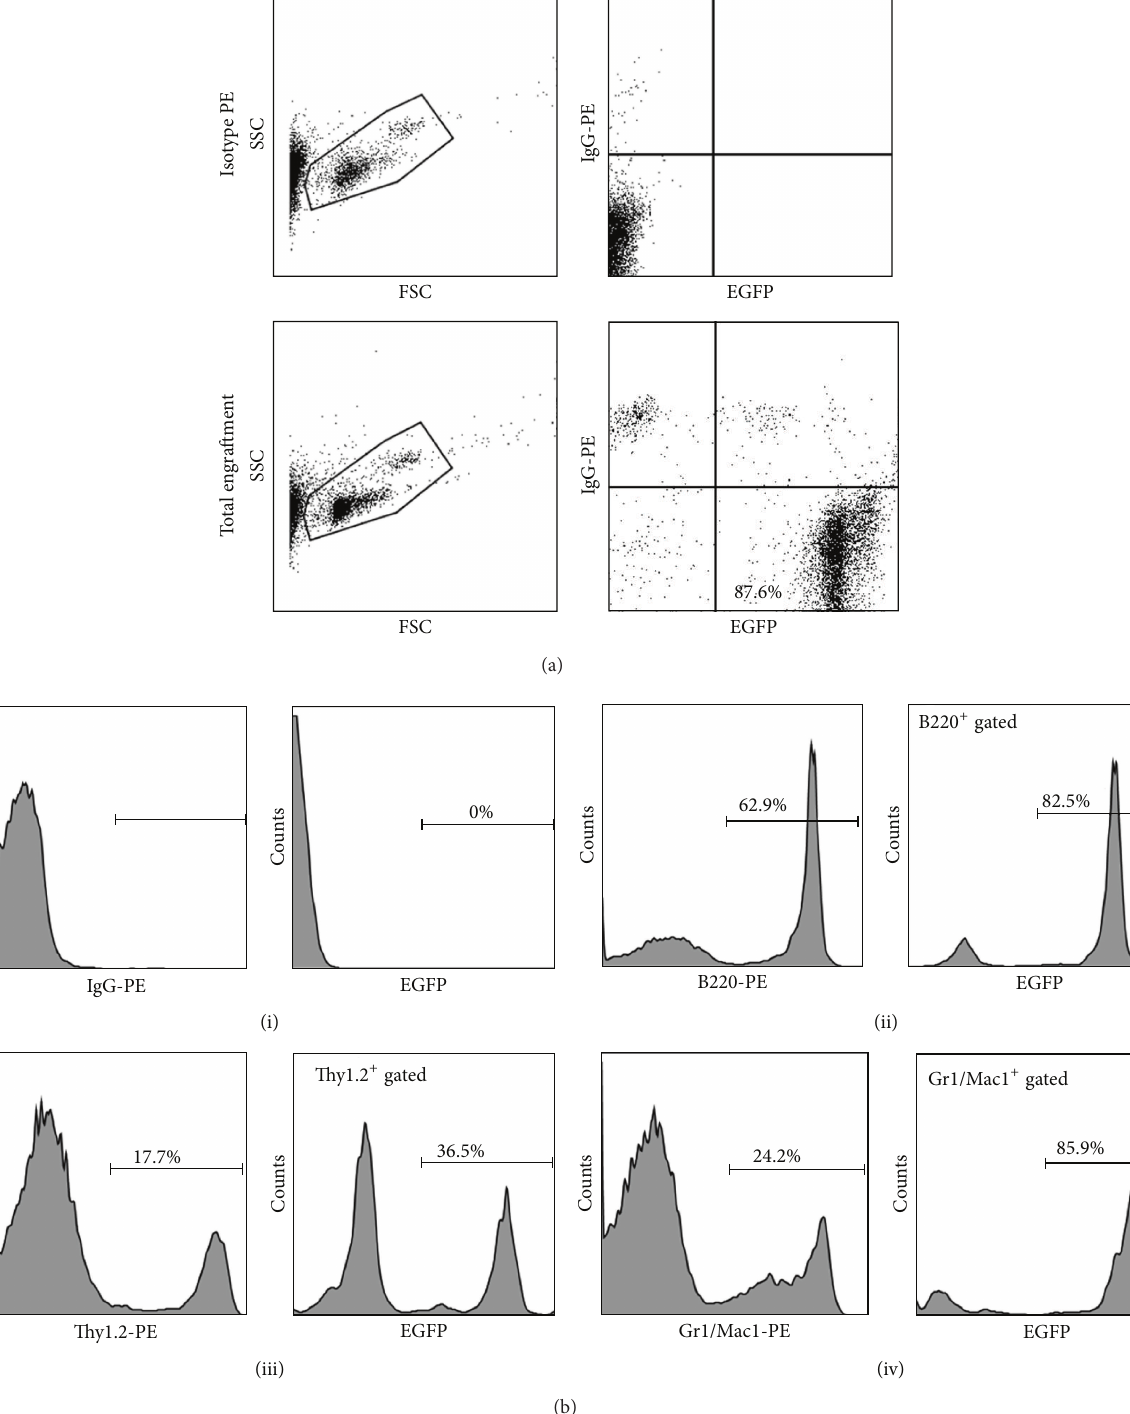
Figure 2: Transplantation of nonadherent bone marrow results in multilineage hematopoietic engraftment. Shown is a representative analysis of total (a) and multilineage (b) engraftment approximately 2 months after transplantation of nonadherent bone marrow cells. Isotype (top panels) forward scatter and side scatter gate is shown (left) with IgG-PE versus EGFP gate (right). Representative total engraftment is shown in Panel(a)(bottompanels)withforwardscatterandsidescattergate(left)andPEandEGFPgatesshown(right).(b)Representativemultilineage engraftment analysis is depicted in Panel (b). The isotype IgG PE gate and the EGFP population gated on the IgG PE population aredepicted in (i). Analysis of B cell (ii), T cell (iii), and granulocyte/macrophage (iv) populations demonstrates EGFP + cells representing 82.5%, 36.5%, and 85.9% of each lineage, respectively. In all dot plots (i–iv), total populations are shown on the left, and EGFP + cells within the gated population are shown on the right. See Table 1 for engraftment for all